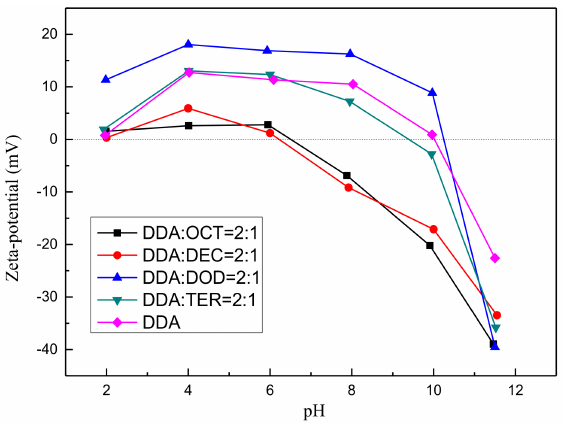
Figure 3. Zeta potentials of muscovite as a function of